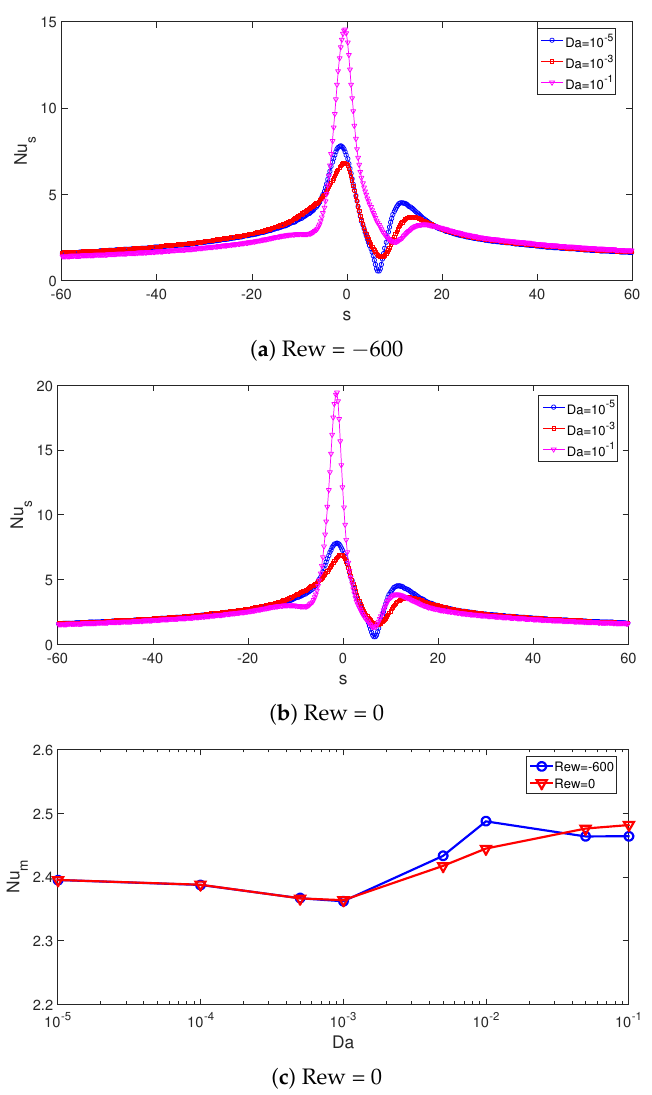
Figure 10. Effects of NPO permeability on the local and average Nu variations at two Rew values (Ha = 10,Mx = − 1,AR =